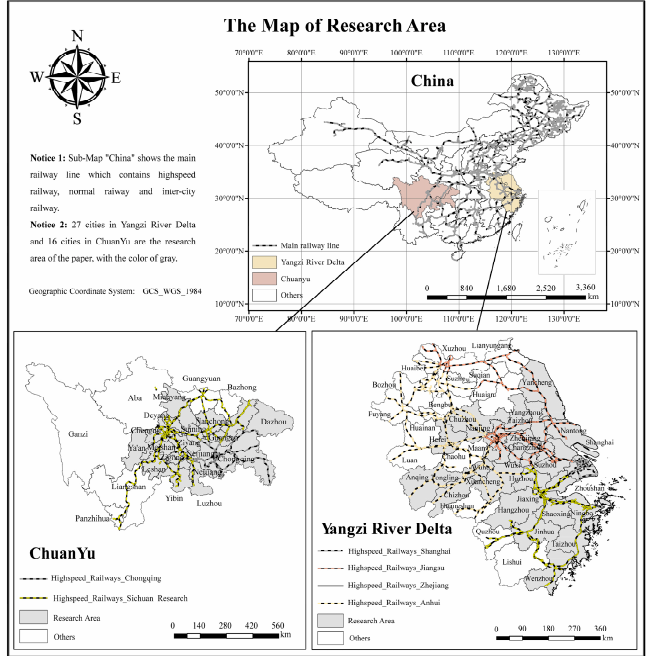
Figure 1. The map of the research area.